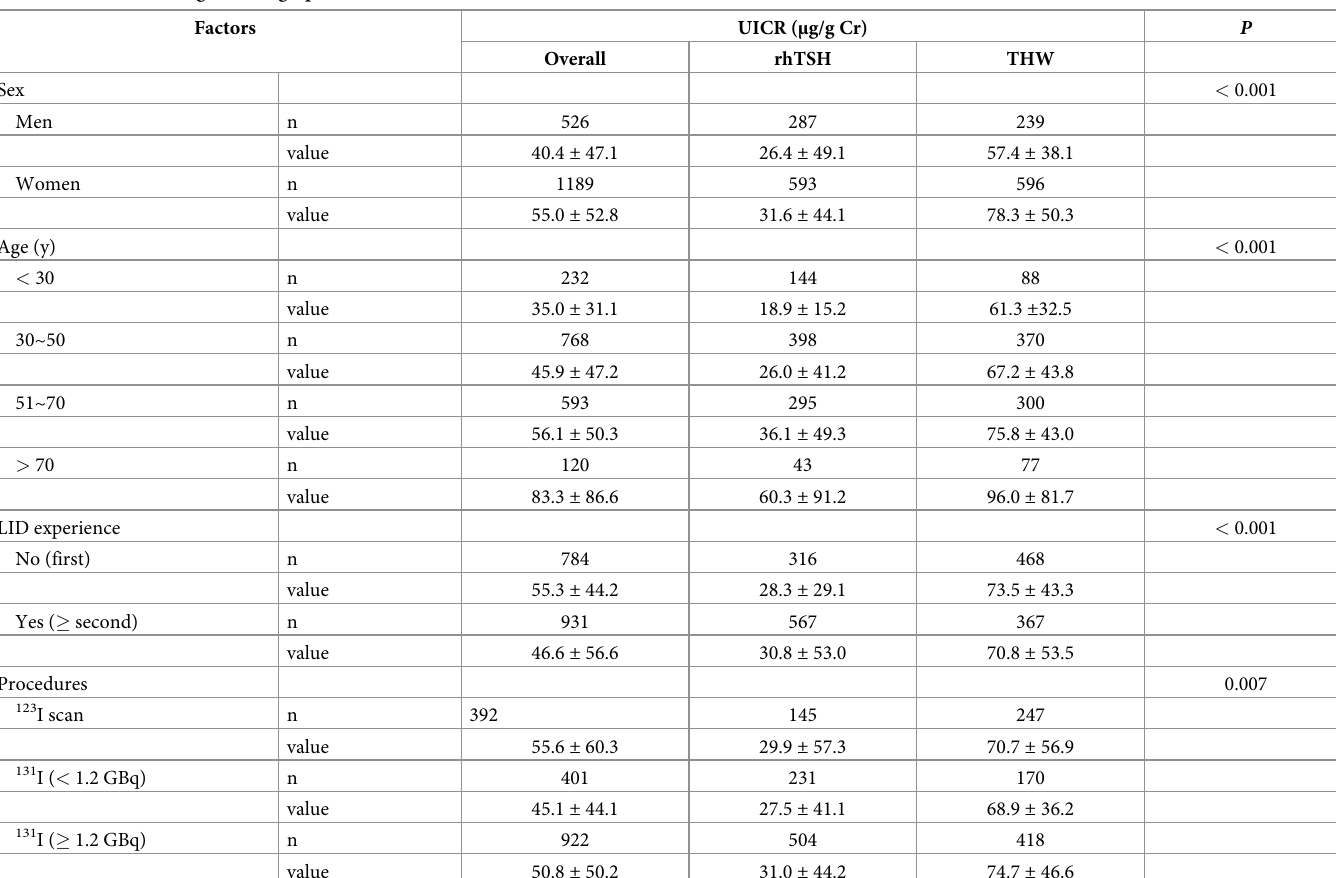
Table 4. UICR according to demographic and clinical factors.